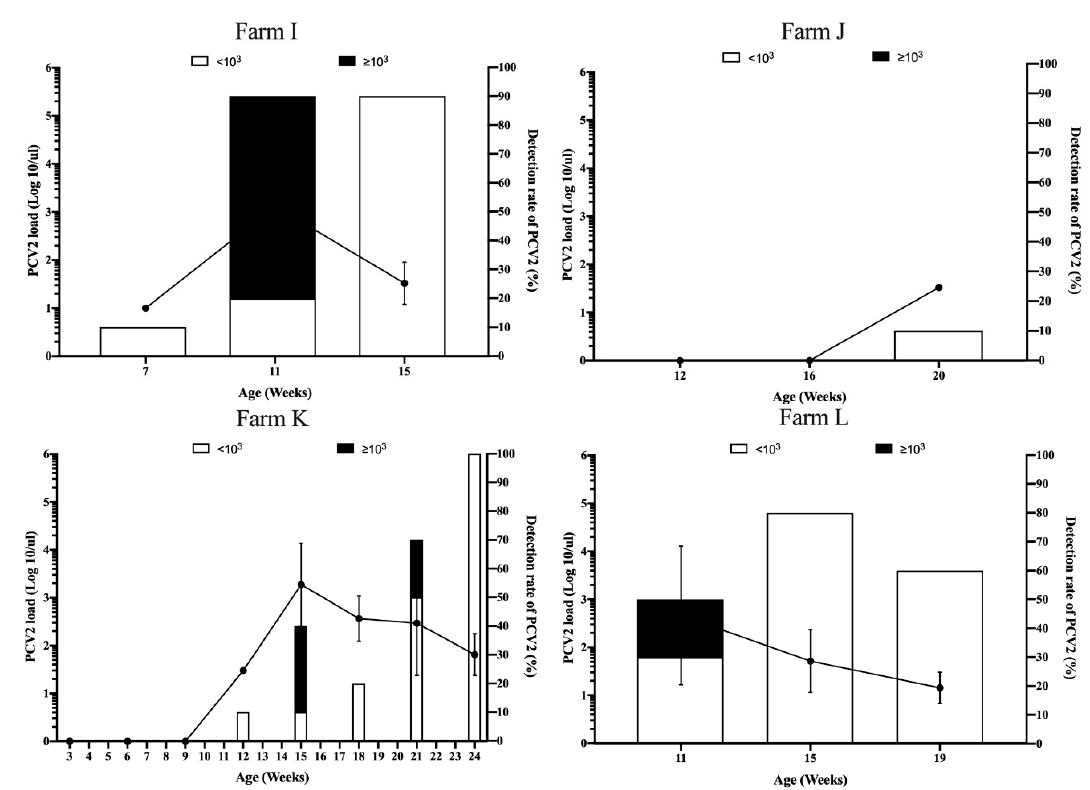
Figure 5. Viremia loads (line graph, left Y axis) and detection rate (bar chart, right Y axis) of porcine circovirus type 2 (PCV2) in pigs born from PCV2 vaccination in sows at 2–4 weeks pre-farrowing, Farms I, J, K, and L. The error bars show the standard deviation (SD) of positive samples.